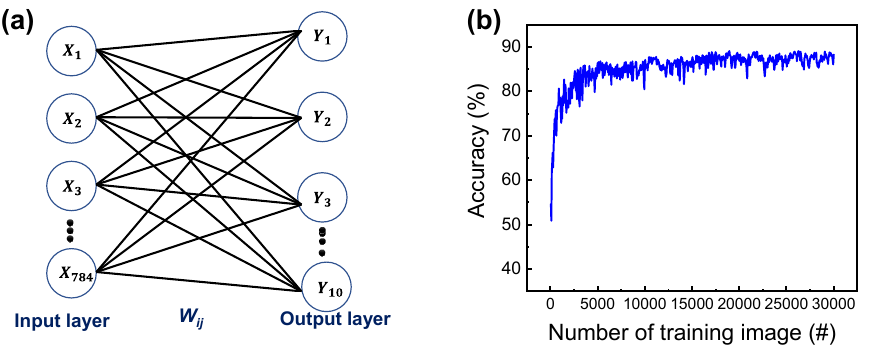
Figure 5. ( a ) Single layer neural network including input neuron, synapse, and output layer, ( b ) accuracy as a function of training epoch.